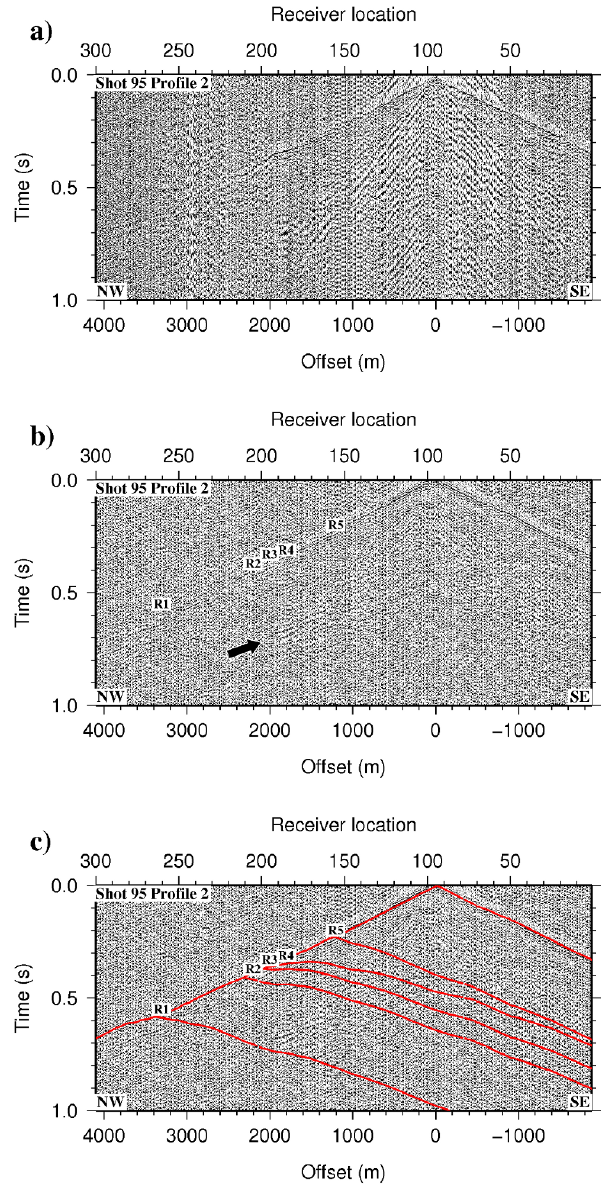
Fig. 6. (a) Raw shot-gather (agc 100ms window and high pass fil- ter (10 20) was used) from S.P. 2. (b) The same shot-gather pro- cessed until step 10 + step 12 and 17. The northwest dipping re- flection marked with black arrow correspond to the reflections seen between CMP 1750 and 1800 at about 0.5s TWT in the stacked sec- tion (Fig. 4a). (c) The processed shot-gather with calculated travel- times for reflections R1–R5